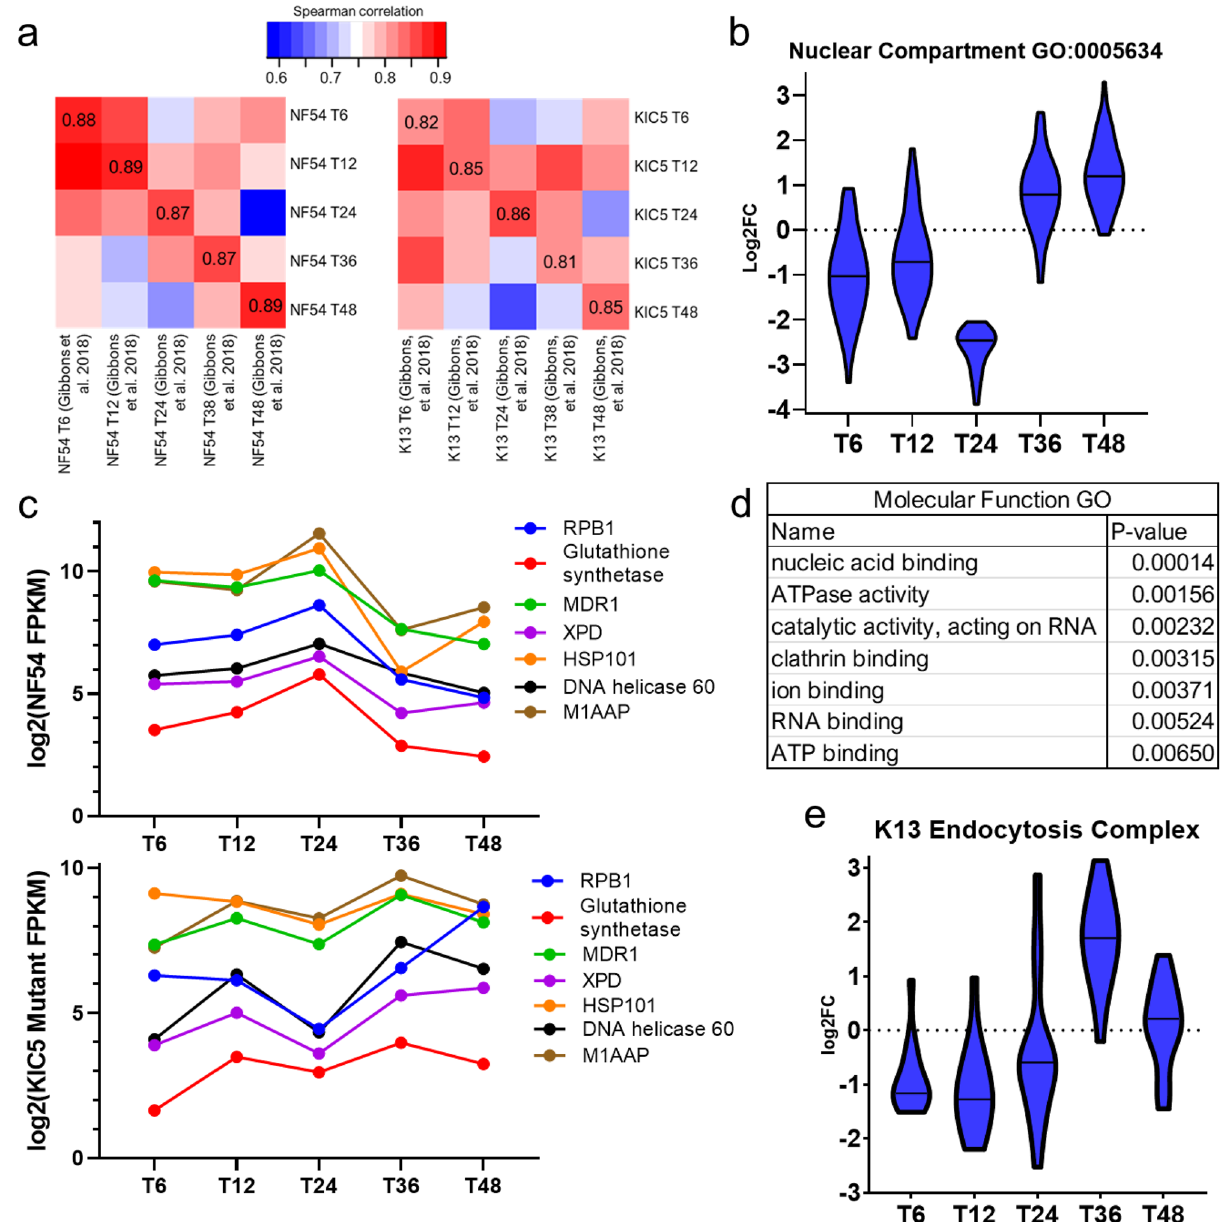
Figure 6. Nuclear metabolic activity is altered due to KIC5 disruption. We identified several similarities between the transcriptome of the K13 mutant, associated with altered DNA replication and repair expression, and the KIC5 mutant. ( a ) Correlation of the NF54 (left) and KIC5 mutant (right) datasets from this study to the WT and K13 mutant datasets from Gibbons et al. 14 (Supplementary Fig. 5). Heatmaps made in R Studio using the pheatmap function and dataset correlation shown via Spearman correlation (Spearman correlation values available in Supplementary Table S8). Gene ontology enrichment analysis of KIC5 mutant expression across the IDC identified differential expression of genes associated with nuclear compartment (GO:0005634) (Supplementary Table S10). Log2-fold change (KIC5 mutant/NF54) analysis via violin plot ( b ) and FPKM analysis of expression in WT (top panel) and mutant (bottom panel) ( c ) shows dysregulation of these genes associated with nuclear compartment GO at 6 hpi, 12 hpi, and 24 hpi. ( d ) Molecular function GO enrichment of nuclear compartment (GO:0005634) genes in the KIC5 mutant. Log2-fold change of genes located in the K13 endocytosis complex shows a similar differential expression to nuclear compartment associated genes, further supporting the link between KIC5, K13, and the K13 complex with altered DNA replication and repair associated pathways (Supplementary Table S14). Log2-fold change data shown for the KIC5 mutant compared to WT expression and graphed on GraphPad Prism